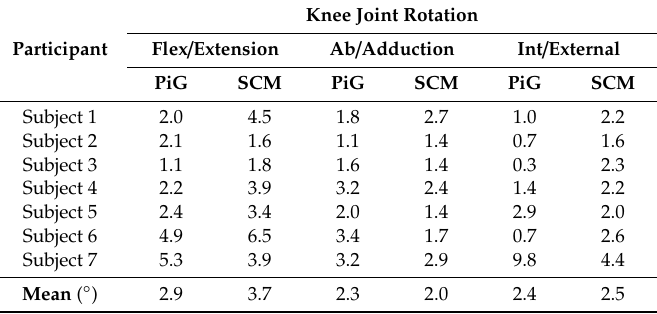
Table 3. Within-subject variability of knee joint rotation over the amputated gait cycle across three trials per participant as calculated by PiG and SCM is shown by the standard deviation, SD.